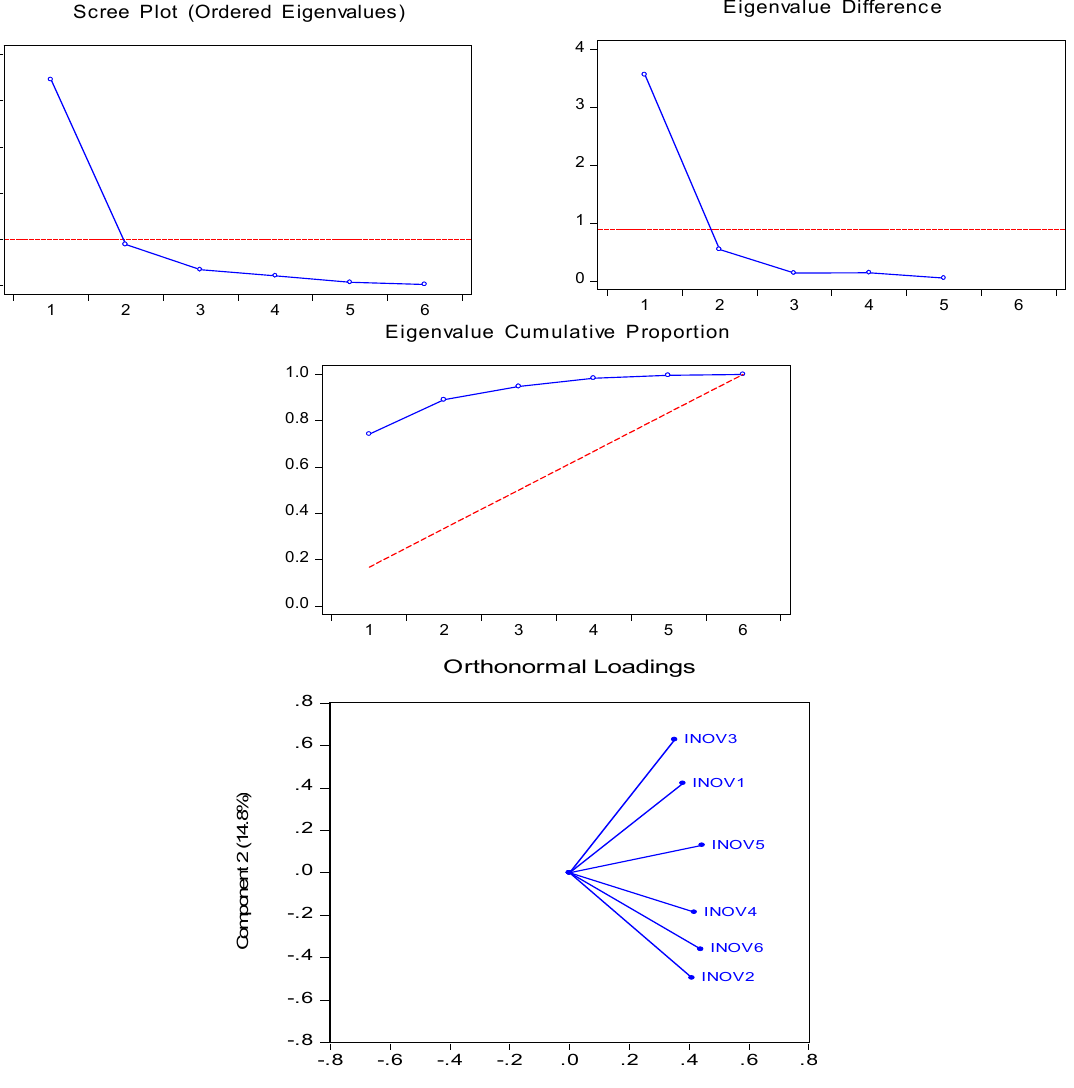
Figure 2. Eigenvalue Plots and Loadings for INOVINDEX. Source: Author’s estimate. Theoretical Consideration